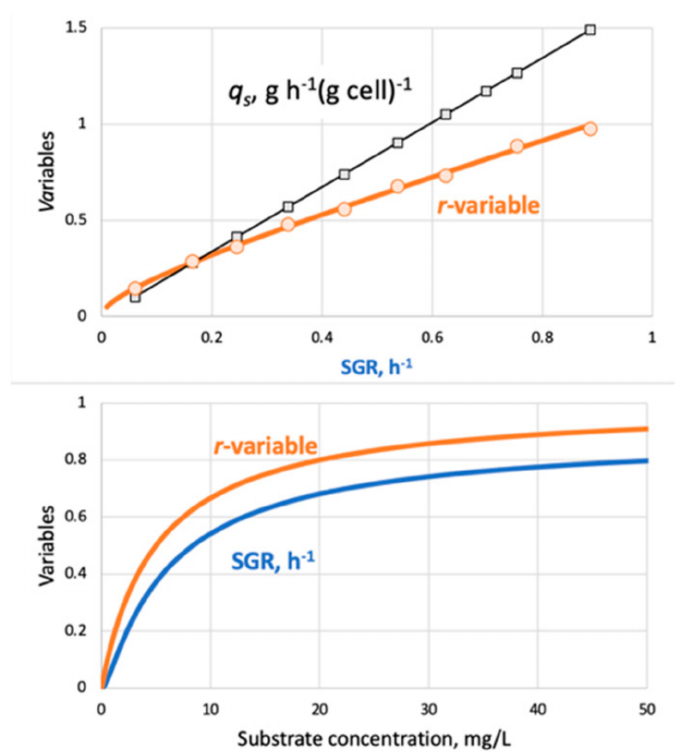
Figure A5. Reconstruction of the missed data on limiting the substrate concentration. Top : Glycerol- limited chemostat, SUR ( q s ), and cell RNA (proxy for r -variable) are plotted vs. µ = D . Bottom : Best-fit reconstruction of the SGR and RNA plots vs. s . The curves were calculated from Equation (A25), minimizing the residual squares with MS Solver.